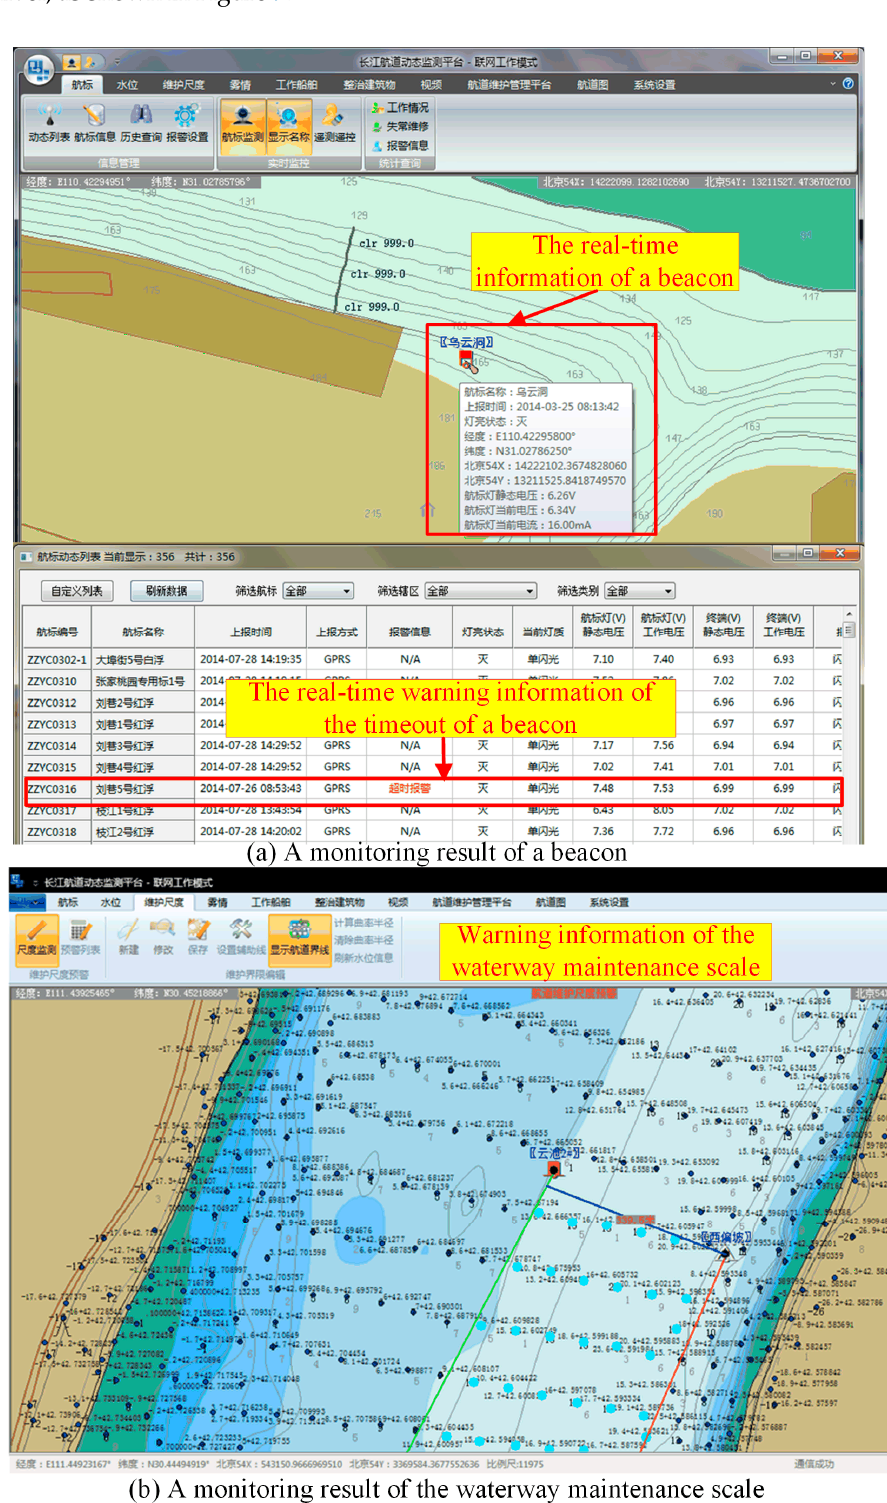
Figure 9. The GeoSensor monitors and analyzes the main channel of the Yangtze River.